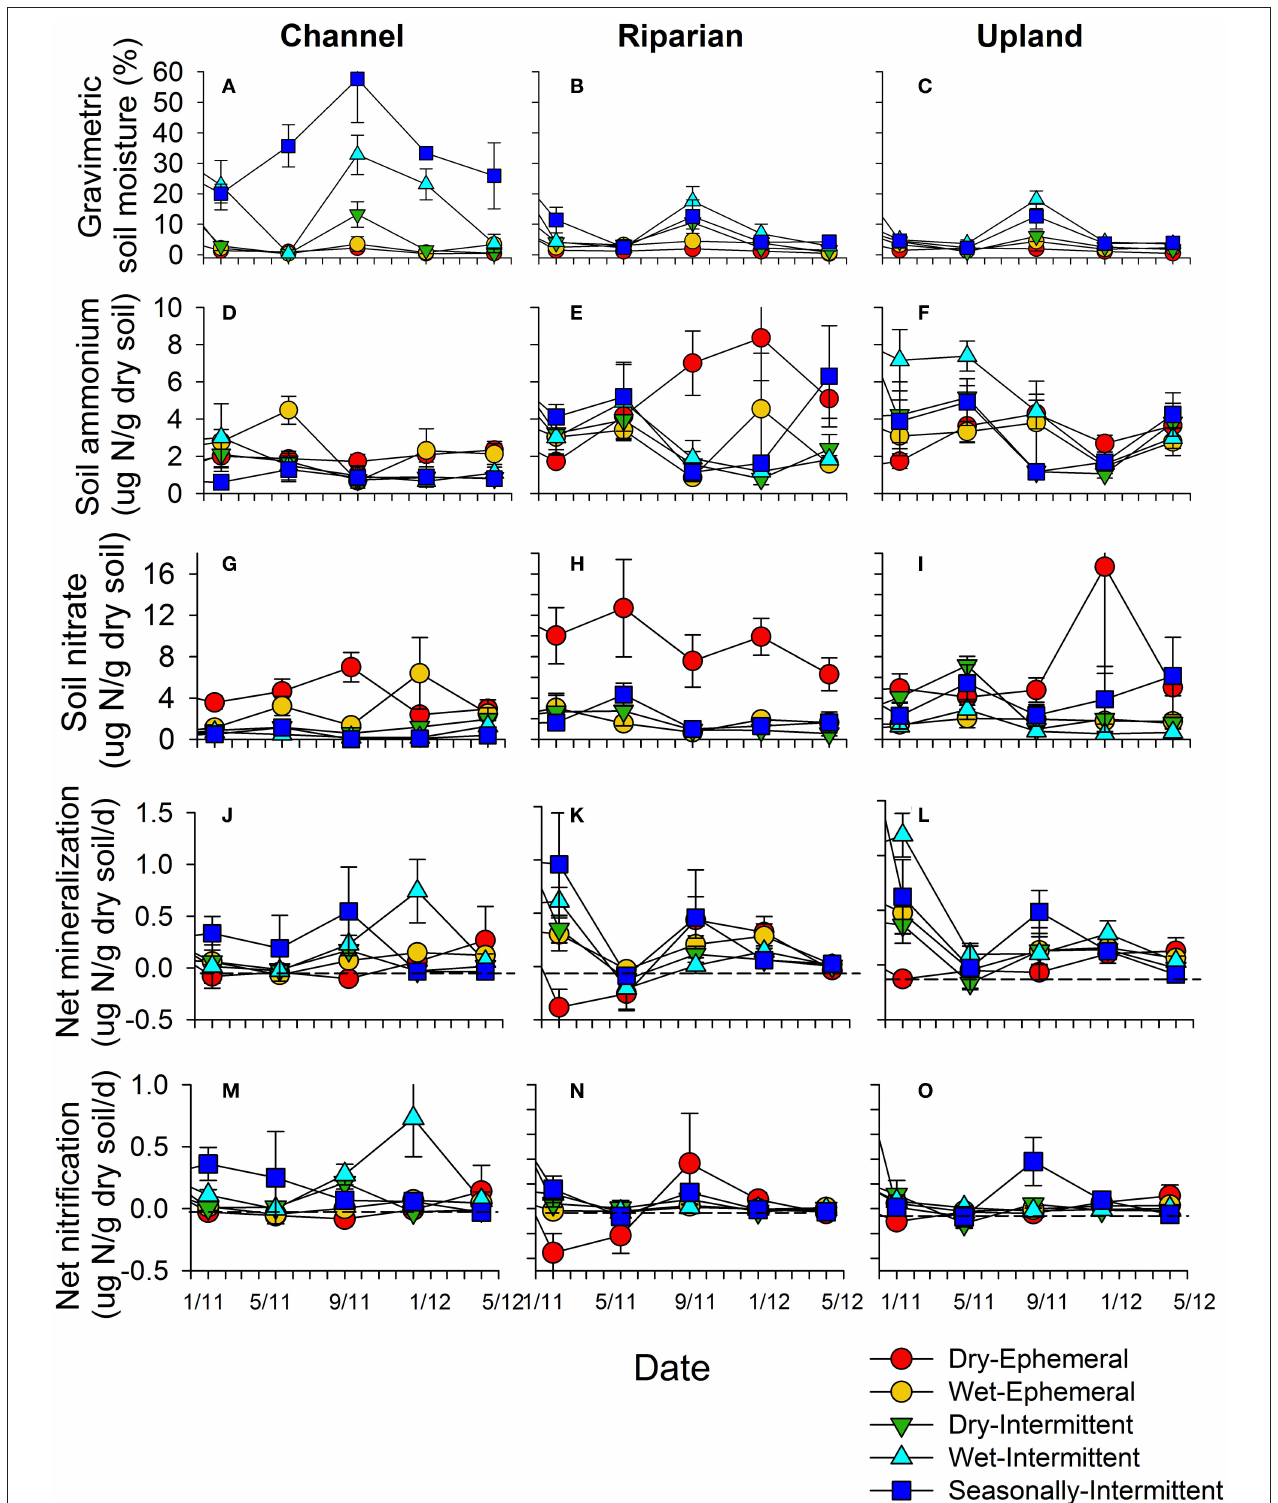
FIGURE 6 | Soil moisture (A–C) , ammonium (D–F) , and nitrate (G–I) pools, and in-situ net mineralization (J–L) and net nitrification rates (M–O) associated with different flow regimes and positions (channel, riparian, and upland) over the course of the decomposition experiment.